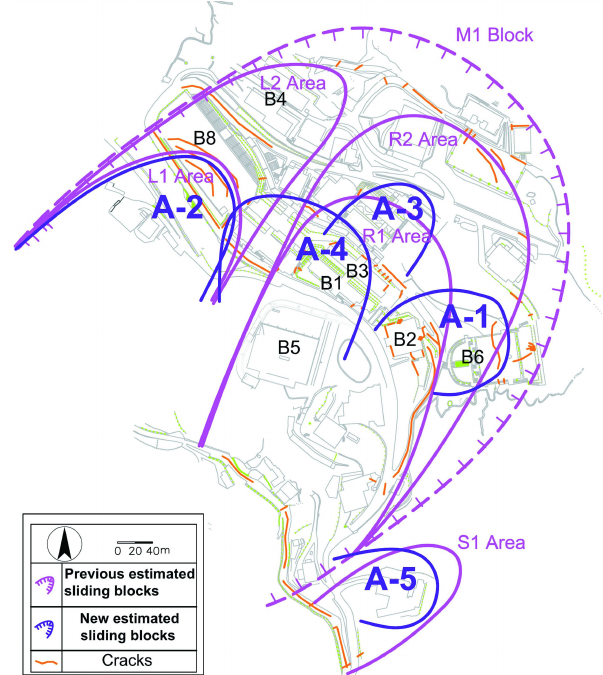
Figure 19. Sliding blocks estimated based on displacement and set- tlement of ground surface